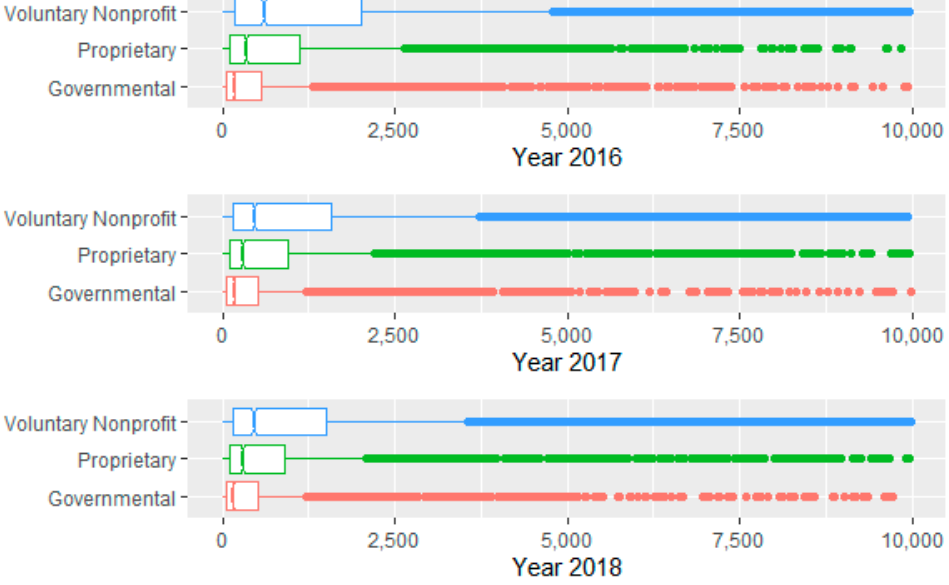
Figure 8. Number of diagnoses by year by type of hospital (some outliers